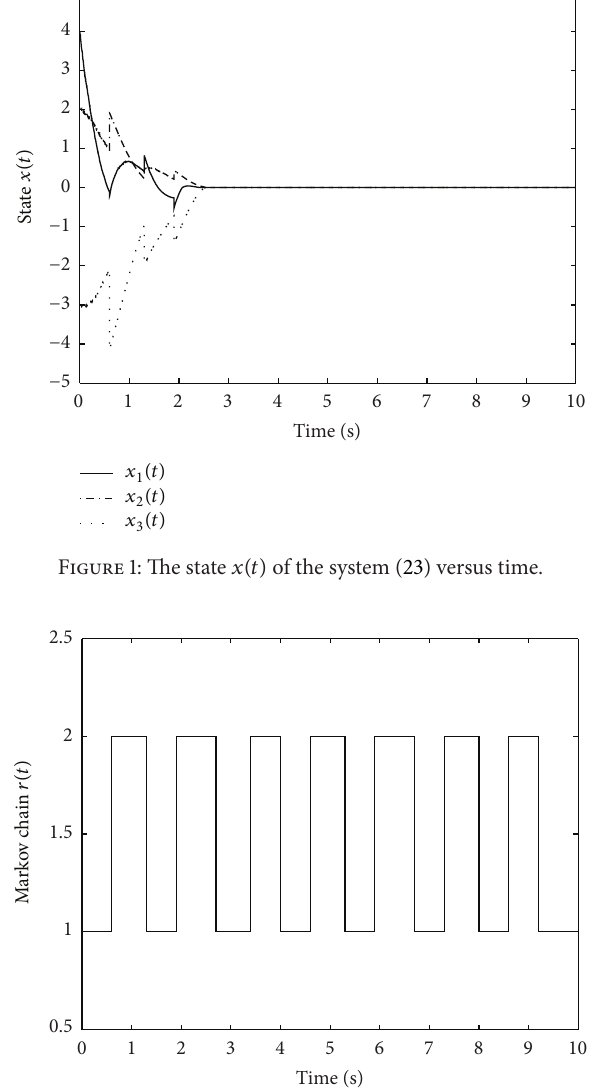
Figure 2: The Markov chain 𝑟(𝑡) of the system (23) versus time.